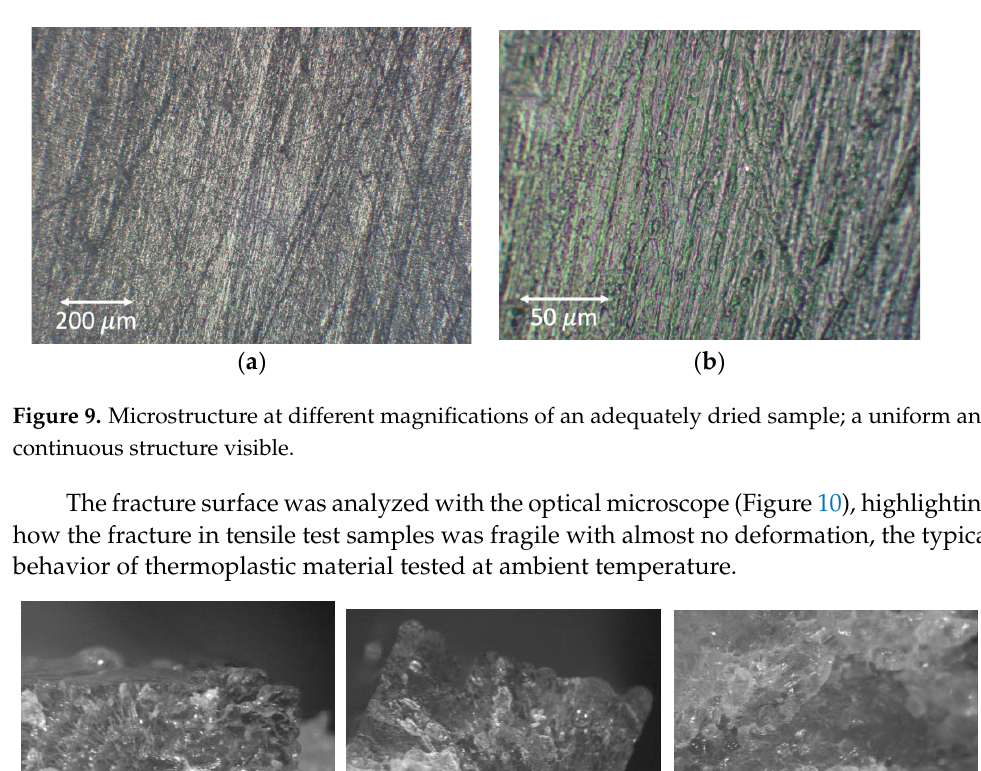
Figure 10. Fractured surface of the tested tensile samples. 4.7. Rapid Tooling Test Case To further assess the correctness of the printing parameters listed in Tables 2 and 7, a demonstrative part has been 3D printed with these conditions. The parameters used include Tn = 380 °C, f = 0 %, IRp = 10%, v = 25 mm/s, h = 0.8, z = 0.25. The ones which differ from Tables 2 and 7 are only IRp and f, which have been slightly modified according to the geometries which had to be produced. As stated in Section 1, one of the main applica- tions of this polymer is the production of rapid tools, reducing cost and time for small batches produced by injection molding or sheet metal forming. This material would be particularly suited for both these applications thanks to its high mechanical strength un- der compression and its thermal resistance. For these reasons, a simple punch and die set for sheet metal forming has been produced. The toolset is intended to perform v-bending on thin metal sheets with thickness between 0.8 and 1.2 mm. The achievable angle is di- rectly related to the stroke of the punch.